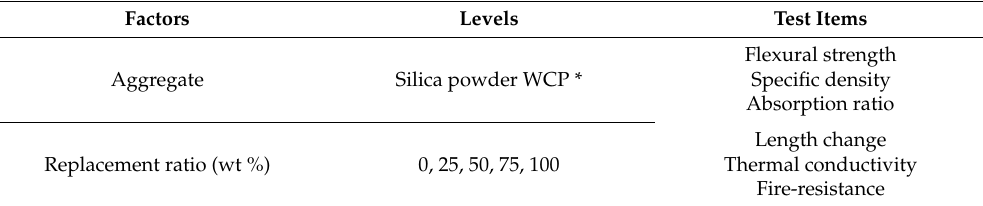
Table 1. Experimental plan.